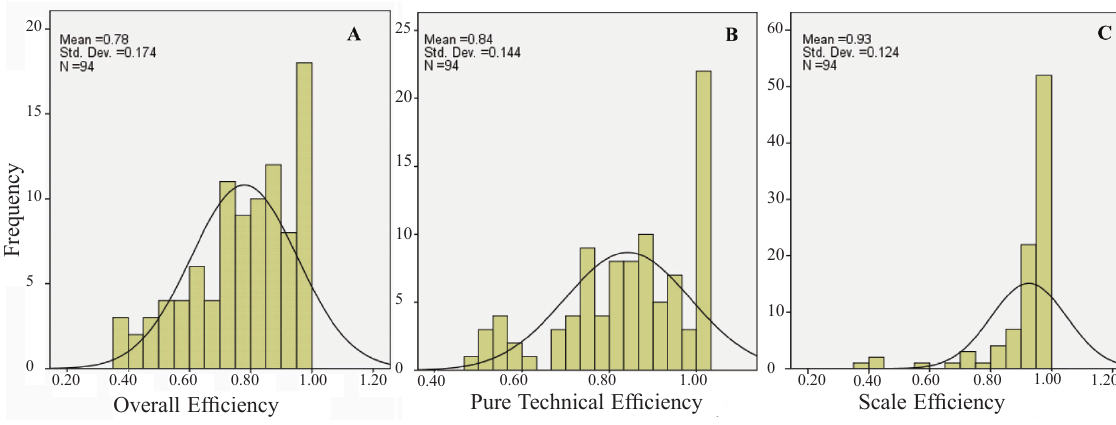
figure 3. frequencies of the oe, PTe and Se